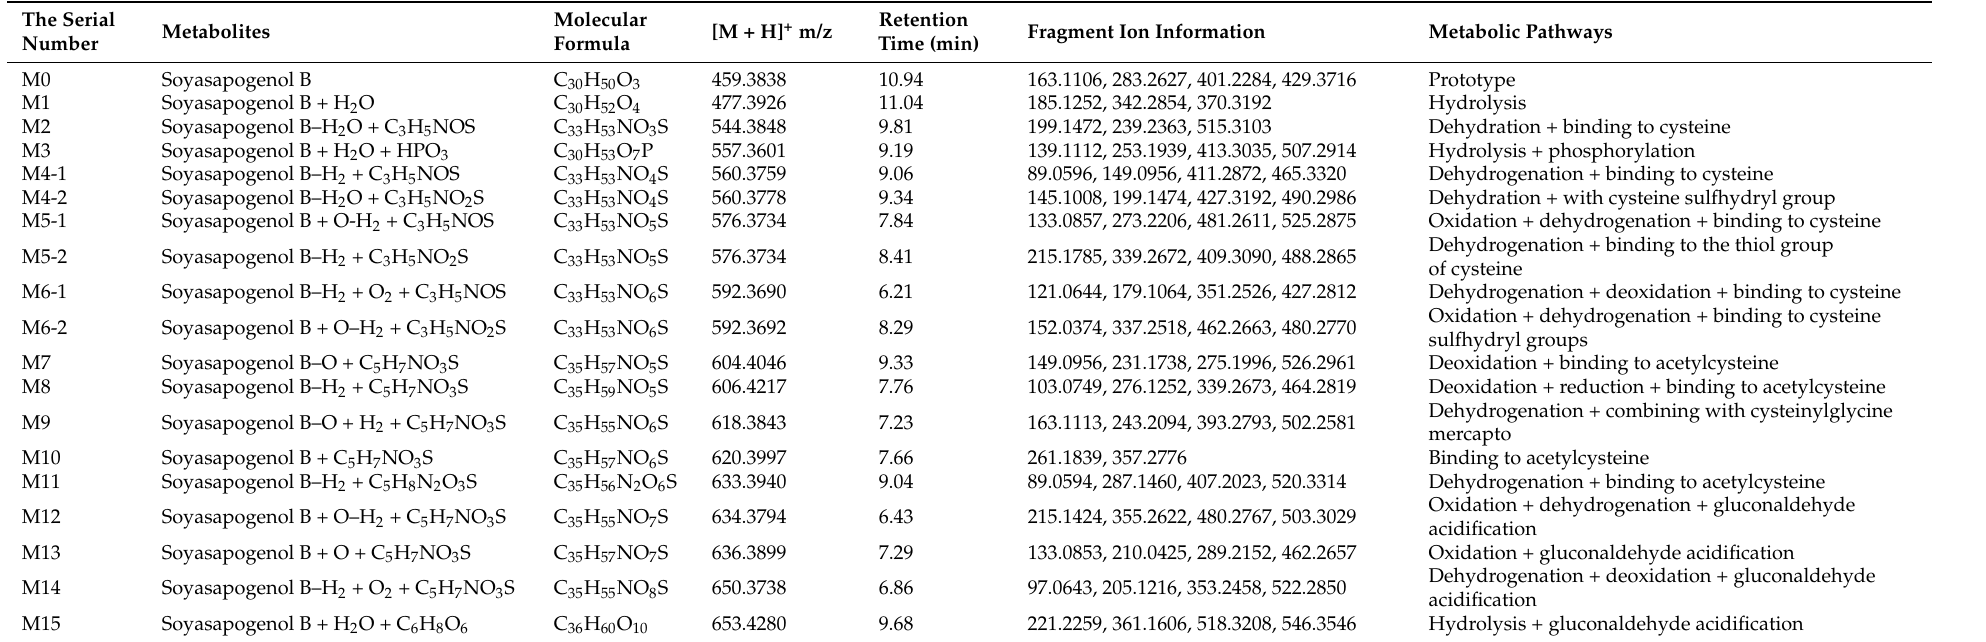
Table 4. Summary of the Mass Spectral Data of Soyasapogenol B and Its Metabolites Detected in Rat